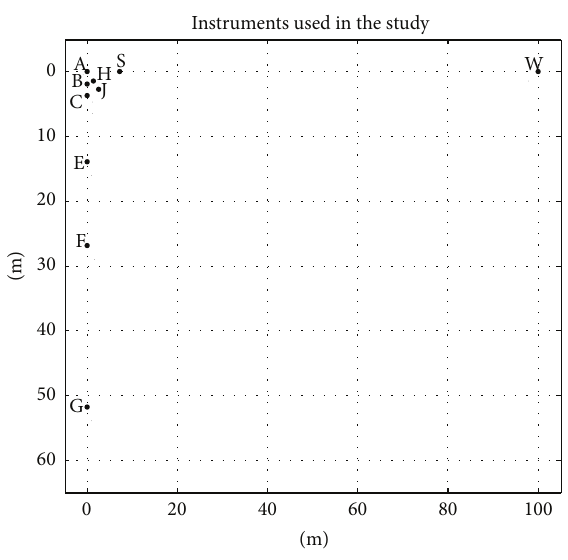
Figure 3: A schematic of only the equipment utilized in the